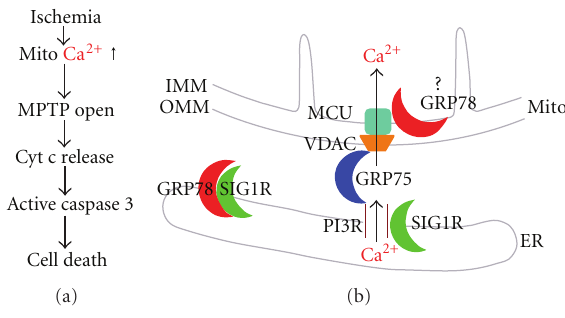
Figure 1: (a) Diagram of cerebral ischemia-induced cell death signaling cascade. (b) Chaperone machinery controls ER-mito- chondria Ca 2+ crosstalk at the MAM. Under normal, resting conditions, SIG1R chaperone forms a complex with GRP78 at the ER. Under stress such as ischemia, SIG1R dissociates from GRP78 and associates with IP3R3 at the MAM, and GRP78 translocates from ER to IMM. ER-mitochondria Ca 2+ transfer controls cell survival or death decision. Cyt c: cytochrome c; ER: endoplasmic reticulum; GRP75: glucose-regulated protein 75; GRP78: glucose- regulated protein 78kDa; IMM: inner mitochondrial membrane; IP3R: inositol trisphosphate receptor; MCU: mitochondrial Ca 2+ uniporter; Mito: mitochondria; MPTP: mitochondrial permeability transition pore; OMM: outer mitochondrial membrane; SIG1R: sigma-1 receptor; VDAC: voltage-dependent anion